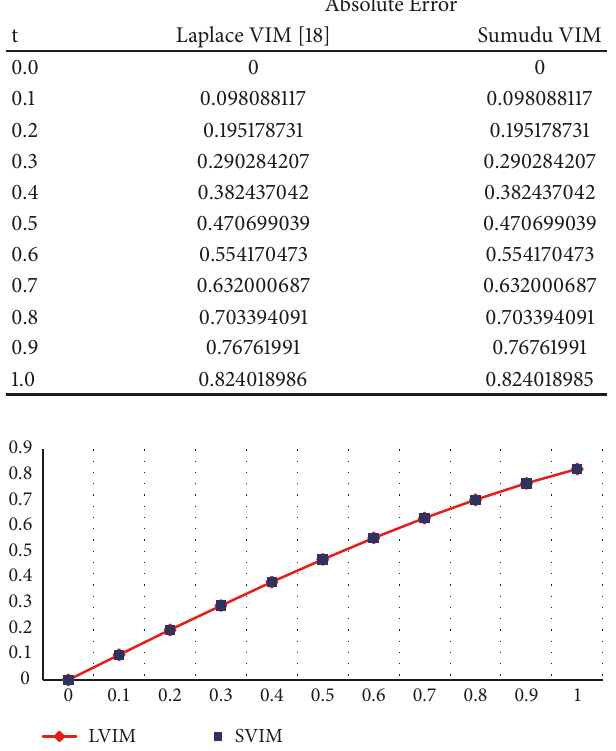
Table 3: Absolute error comparison representing Example 3. Absolute Error